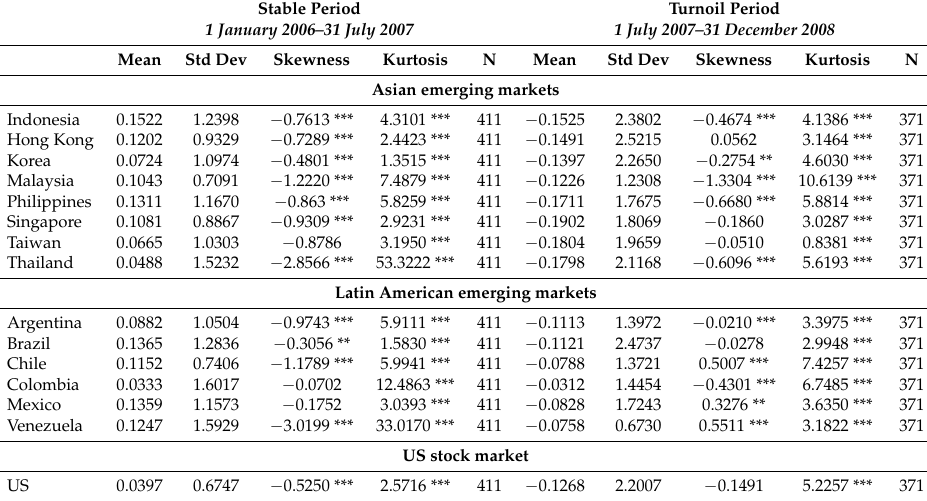
Table 4. Descriptive statistics on stock returns: The US subprime